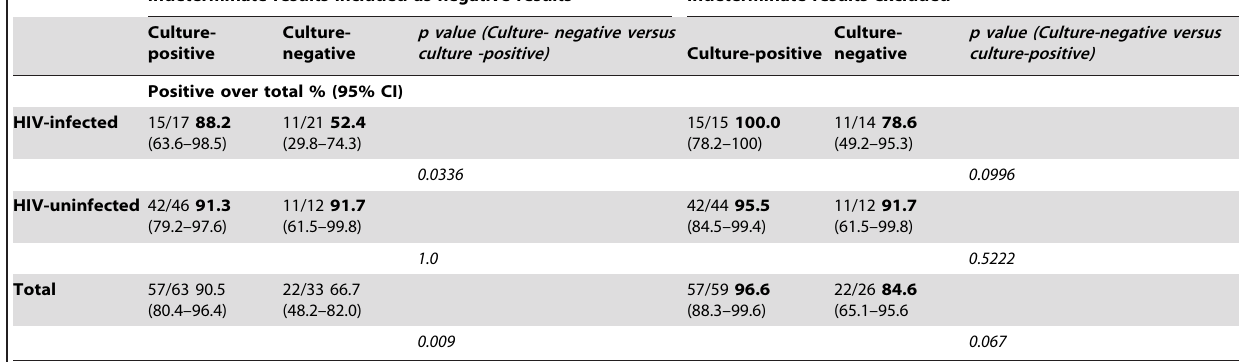
Table 5. Sensitivity of QFT-GIT calculated over the total of patients tested (indeterminate results included as negative results) and only over the interpretable results (indeterminate results excluded) in PTB patients stratified by HIV status according to culture status.